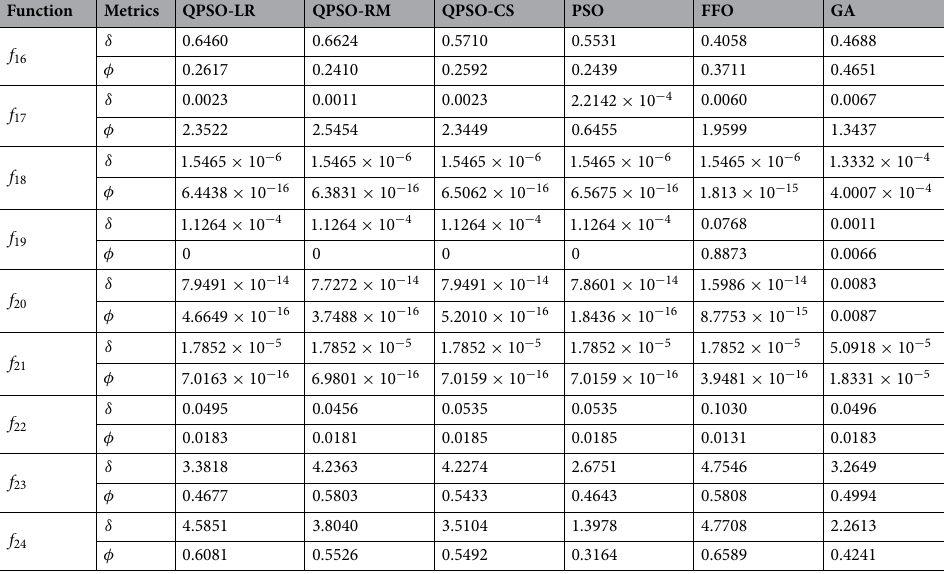
Table 3. Accuracy and precision metrics for fixed-multimodal benchmark functions with Tmax = 1000 and Texp =